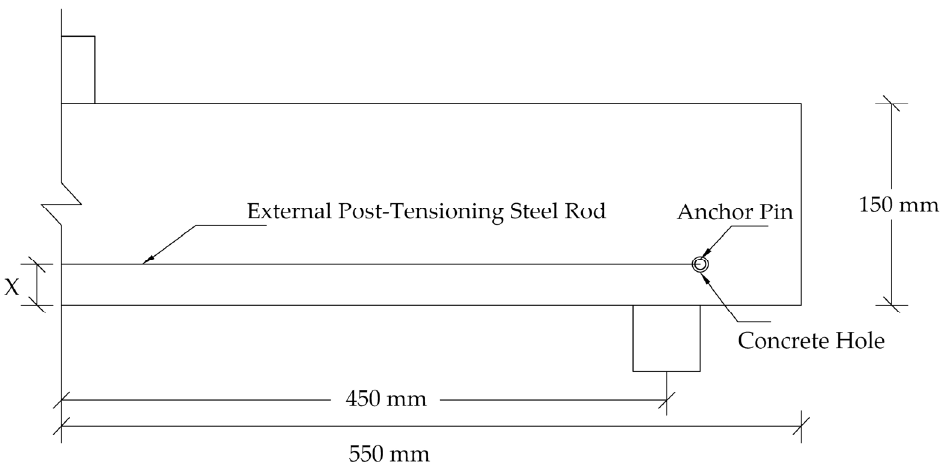
Figure 11. Schematic external post-tensioning (EPT) setup for beam T6.